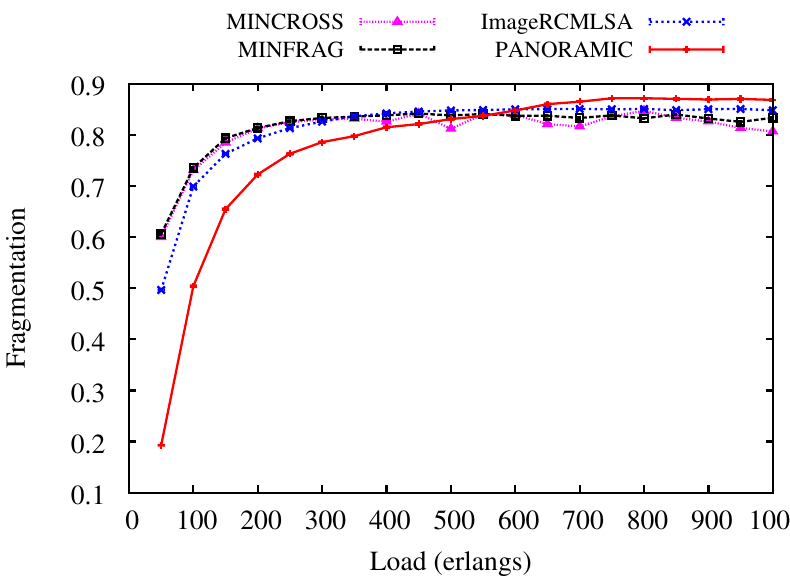
Figure 10. Fragmentation Ratio for USA topology.